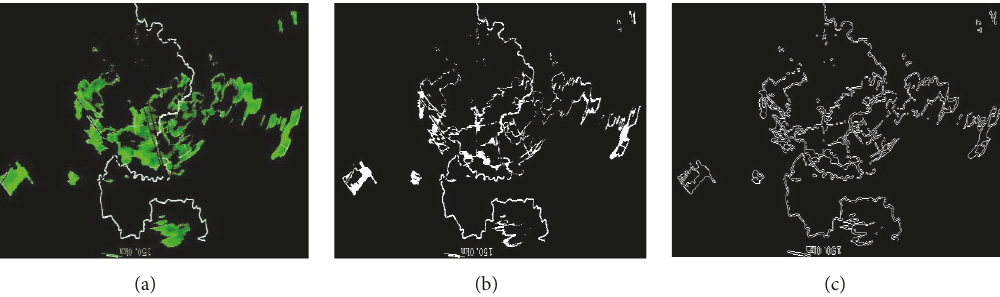
Figure 8: From (a) to (c): image after extracting the green elements, corresponding binary image, and contour lines.